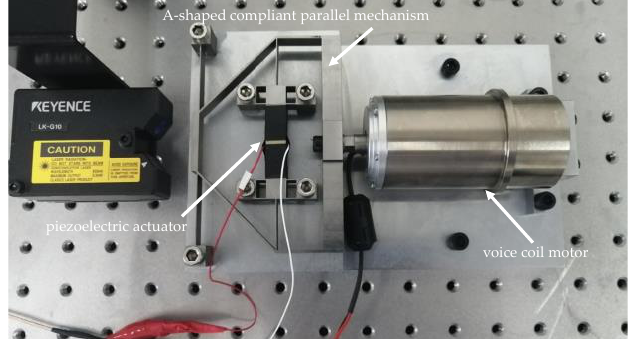
Figure 7. Experimental setup of PDCNS prototype.